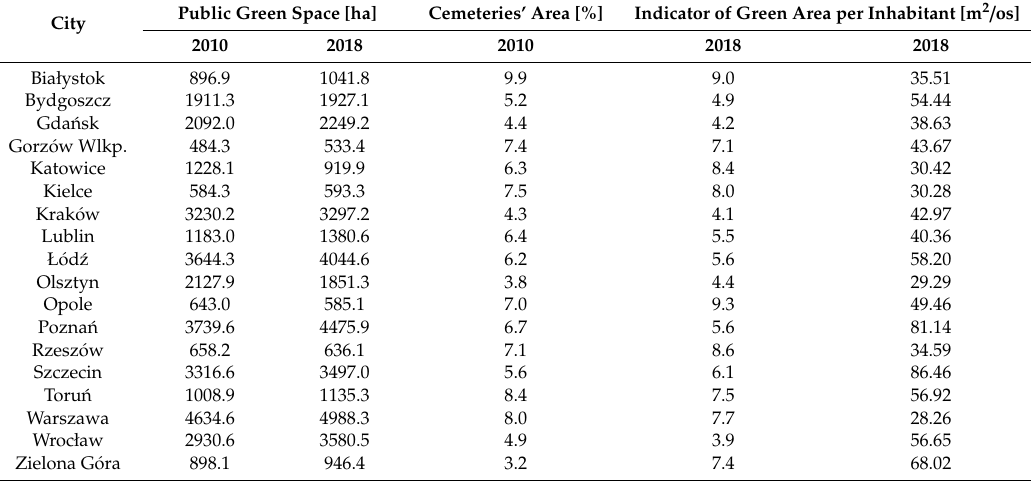
green area in individual voivodeship cities in Poland.